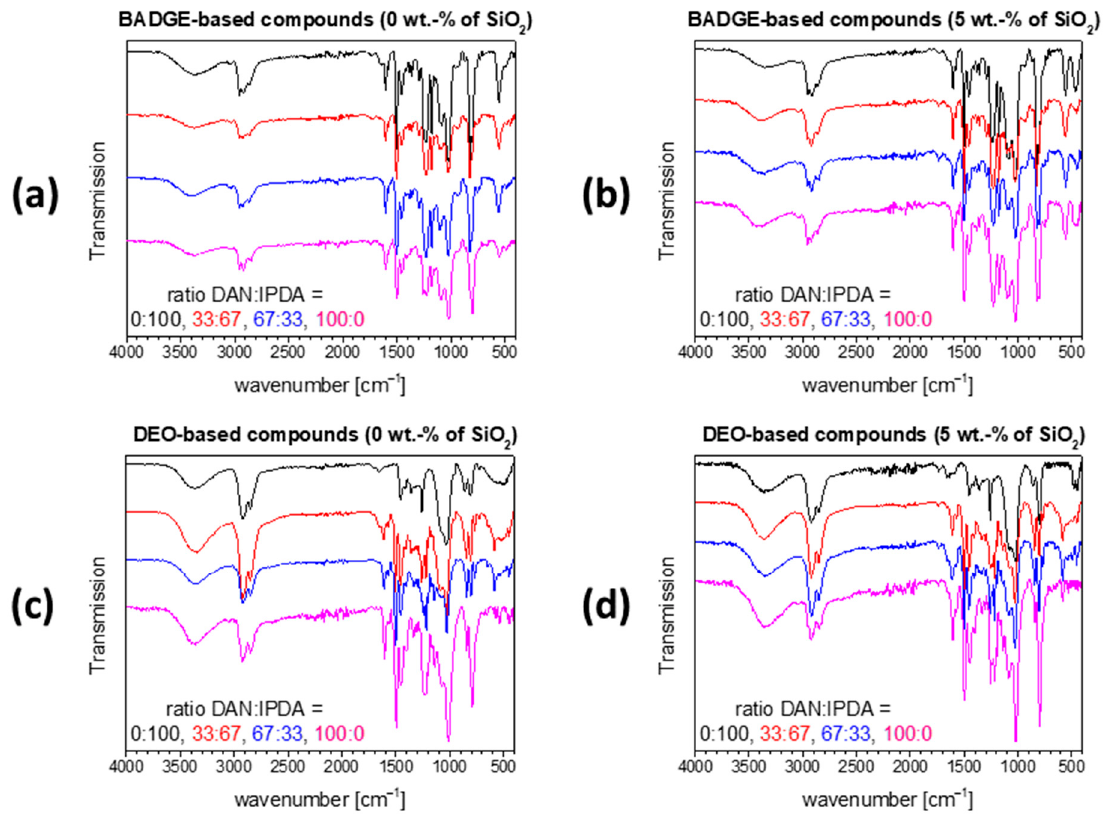
Figure 4. FT-IR-ATR spectra of the BADGE-based formulations without ( a ) and with silica nanofillers ( b ) as well as the DEO-based formulations without ( c ) and with silica nanofillers ( d ) after the curing reaction.